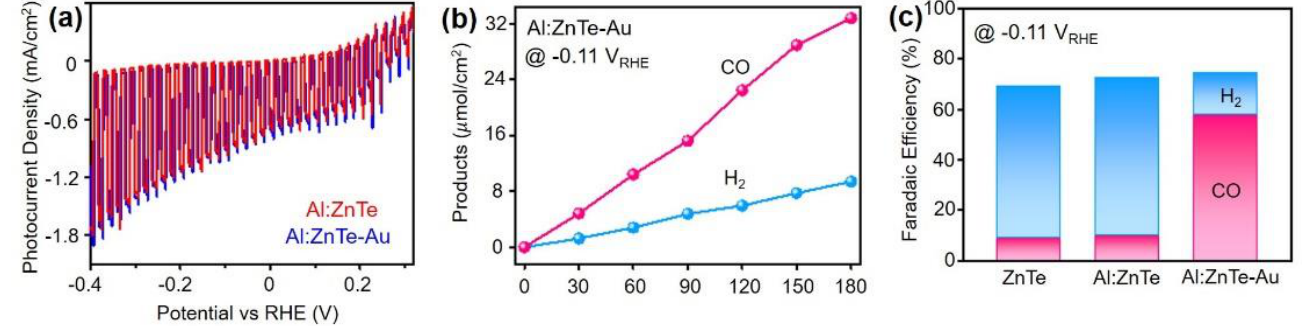
Figure 5. ( a ) J-V plot (scan rate of 5 mW/s) of Al:ZnTe and Al:ZnTe-Au. ( b ) Time-profiled product distribution. ( c ) Faradaic efficiency of each product of H 2 and CO for ZnTe, Al:ZnTe, and Al:ZnTe/Au photocathodes at − 0.11 V RHE .